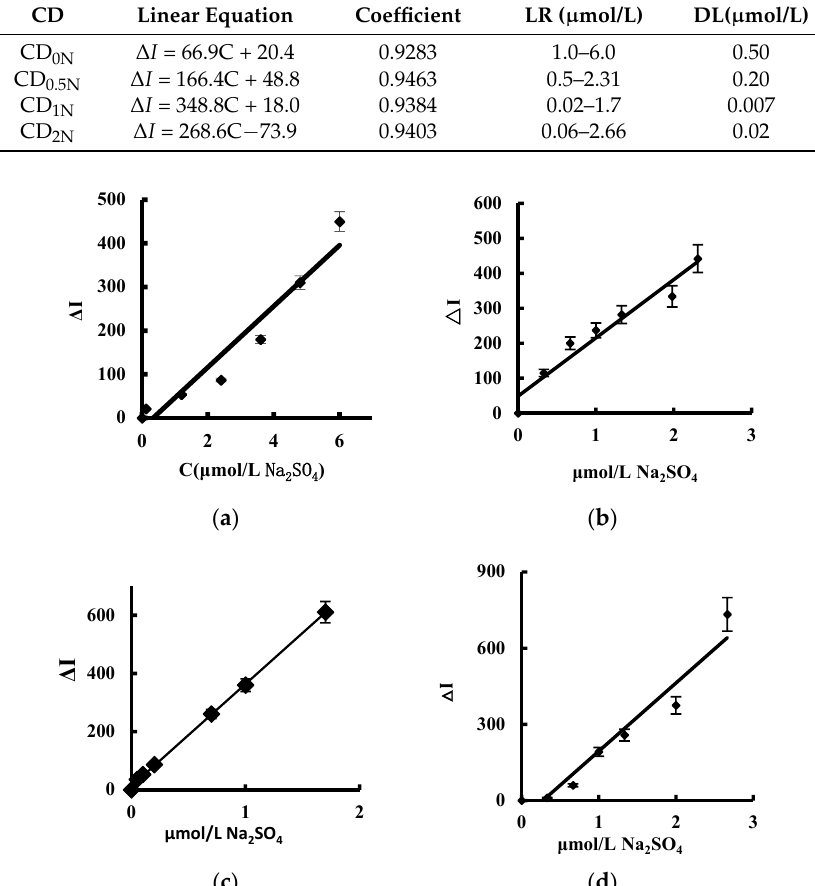
Figure 7. Working curves for CD catalytic-SERS method. 4.2 µ mol/L HAuCl 4 + 2.5 mmol/L H 2 O 2 + 5 µ g/mL CD + 53 µ mol/L BaCl 2 + 0.33 µ mol/L VB4R. ( a ): CD 0N ; ( b ): CD 0.5N ; ( c ): CD 1N ; ( d ): CD 2N .